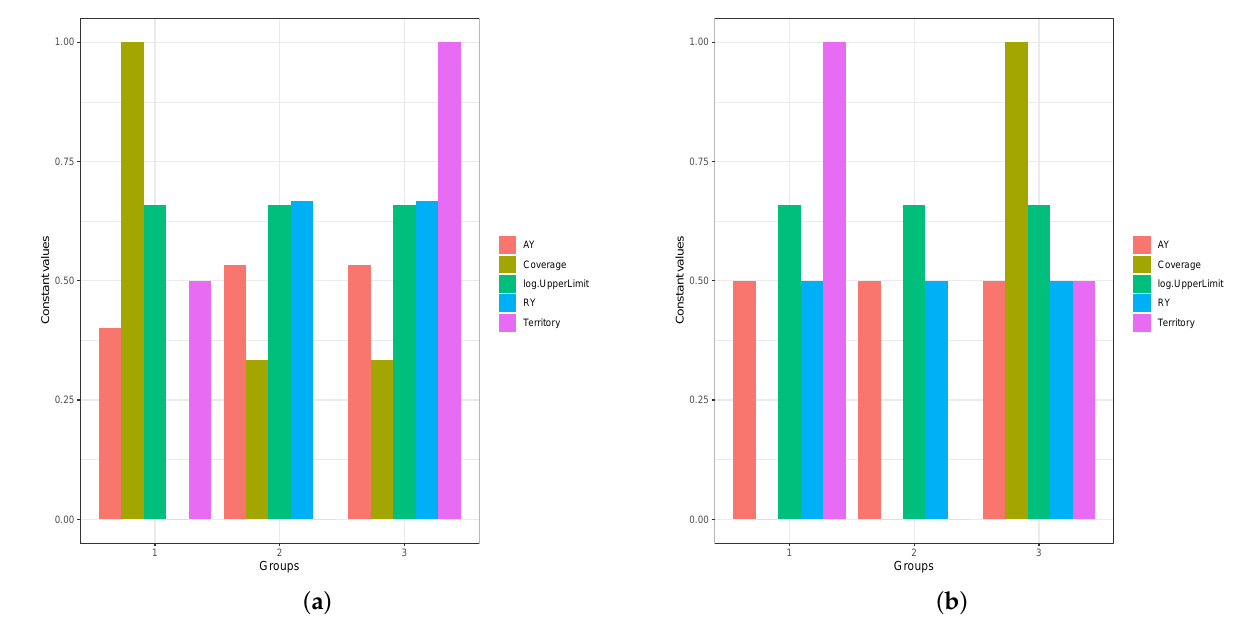
Figure 2. Bar plots for values of unevaluated risk factors in each group, where the value in each group is at the cluster mean. ( a ) Claim Counts. ( b ) Loss Amounts.